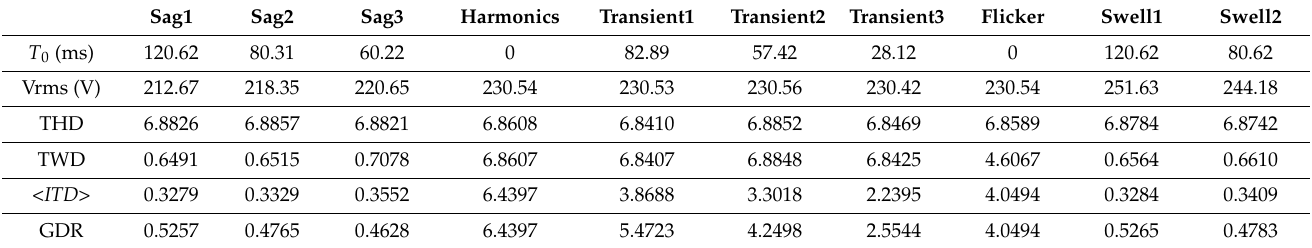
Table 4. Summary of Power Quality Indices for the case